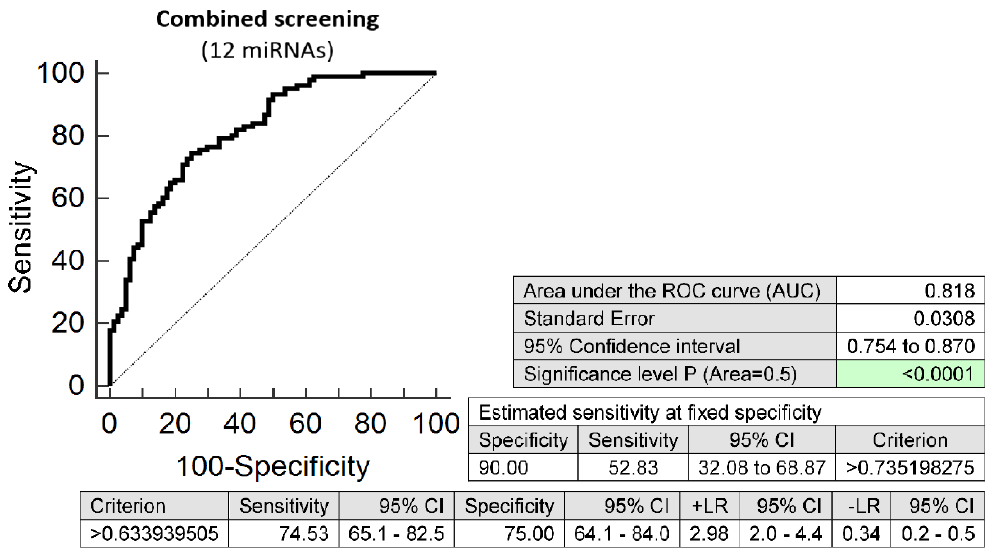
Figure 1. ROC analysis—the best combination of microRNA biomarkers in early prediction of preterm delivery. The combination of miR-16-5p, miR-20b-5p, miR-21-5p, miR-24-3p, miR-26a-5p, miR-92a-3p, miR-133a-3p, miR-145-5p, miR-146a-5p, miR-155-5p, miR-210-3p, and miR-342-3p showed that at 10.0% FPR 52.83% preterm pregnancies had aberrant microRNA expression profile in the whole peripheral venous blood in early stages of gestation.